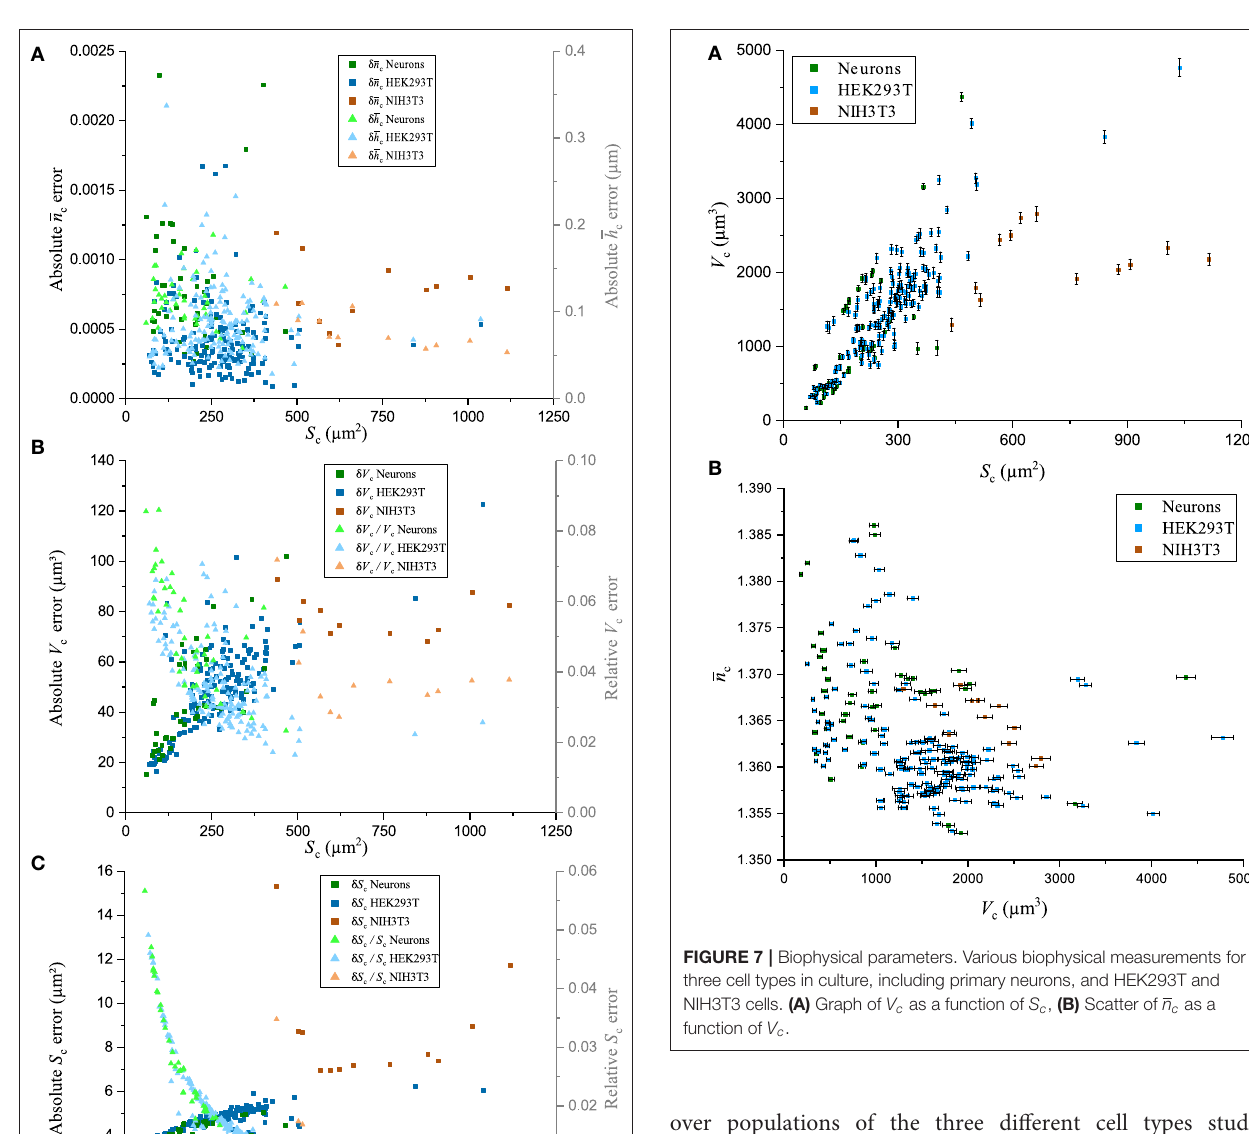
over populations of the three different cell types